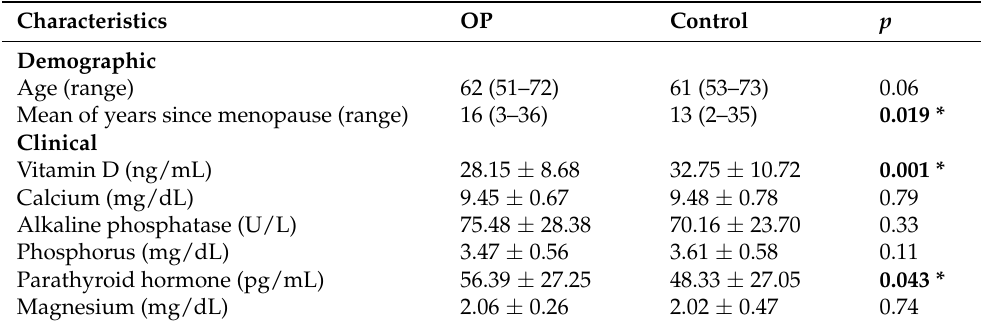
Table 1. Demographic and clinical characteristics of patients with osteoporosis (OP) versus control group.